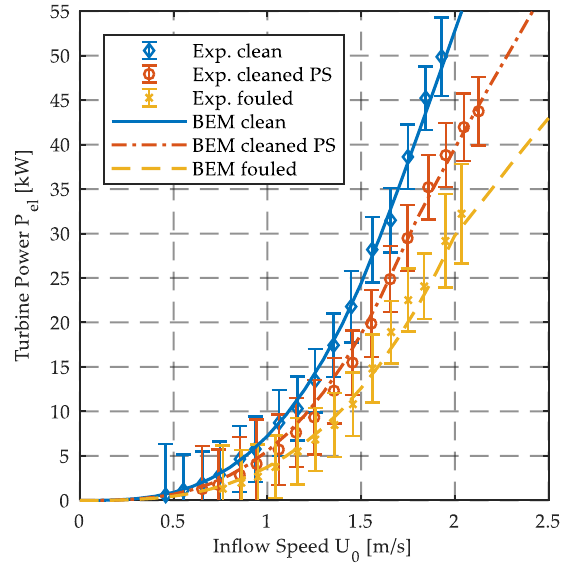
Fig. 13 Effect of fouling on the measured and BEM